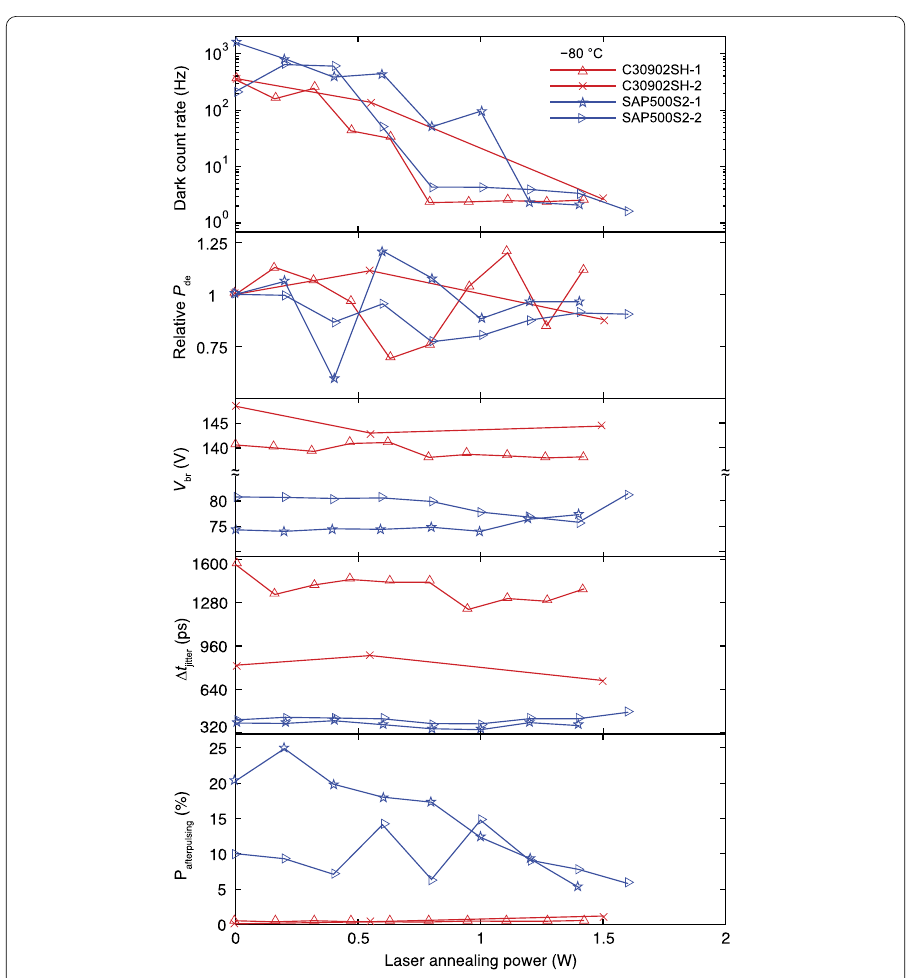
Figure 8 Characteristics of C30902SH and SAP500S2 APDs after laser annealing. Points at zero power show the initial characteristics before laser annealing. Each point shows a measurement after successive laser illumination